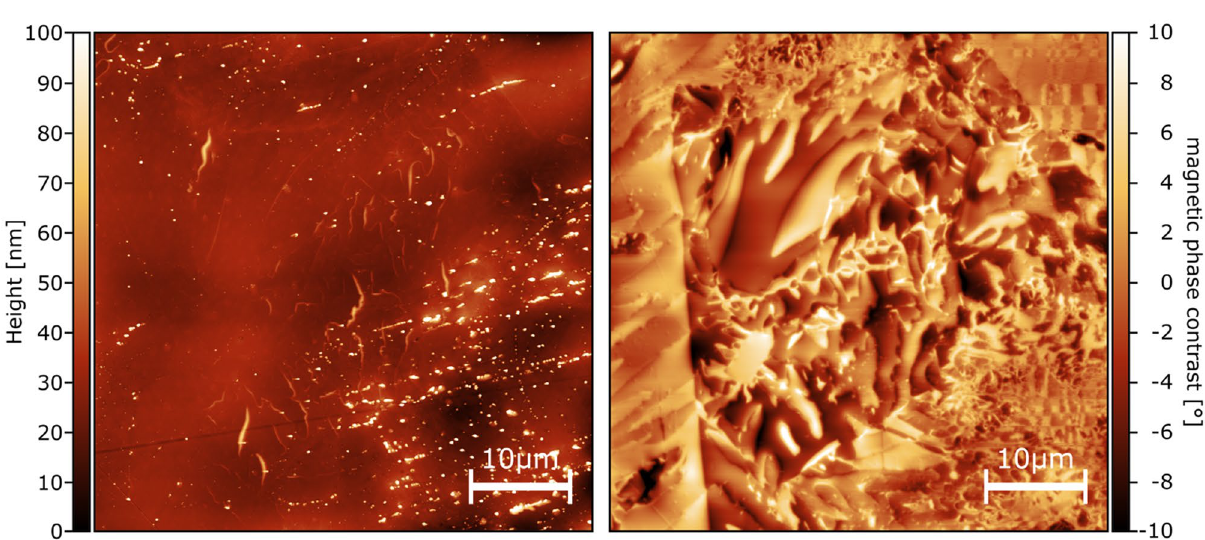
Figure 8. Magnetic force microscopy measurement of the Mn 55 Al 45 C 2 (VC) 1 sample. Left image shows the topography with clear visible lines of precipitates. The right image illustrates the magnetic domains and a correlation between small domains and the location of the precipitates can be